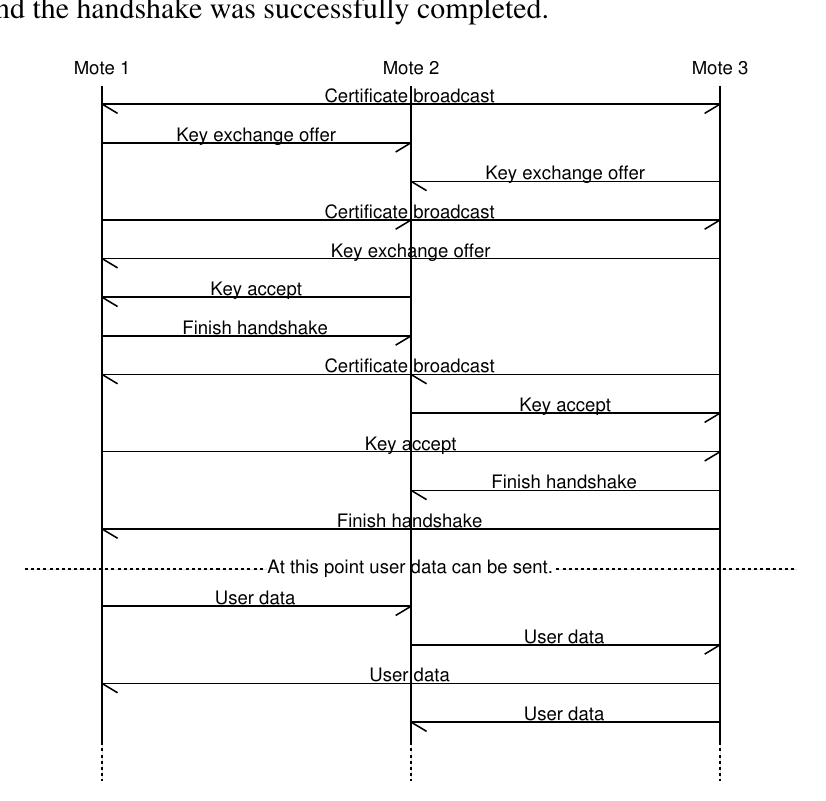
Figure 1. Example handshakes between three